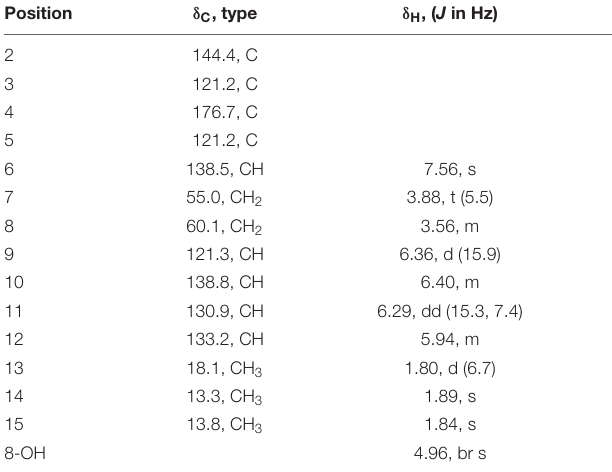
TABLE 4 | 1 H NMR (500 MHz) and 13 C NMR (125 MHz) data for 4 in DMSO- d 6 ( δ in ppm, J in Hz).